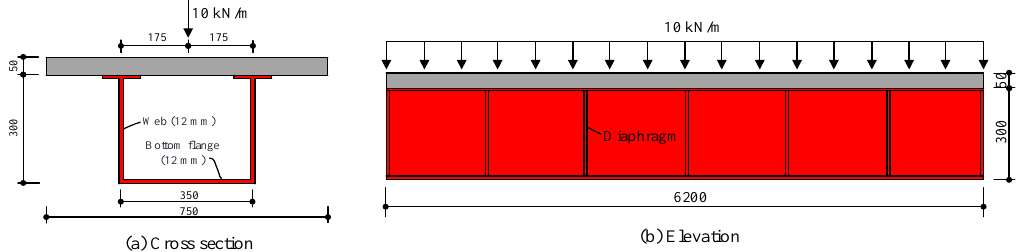
Figure 2. Geometric dimensions and load layout of the curved composite box beam used for validation (unit: mm): ( a ) cross section, ( b ) elevation.